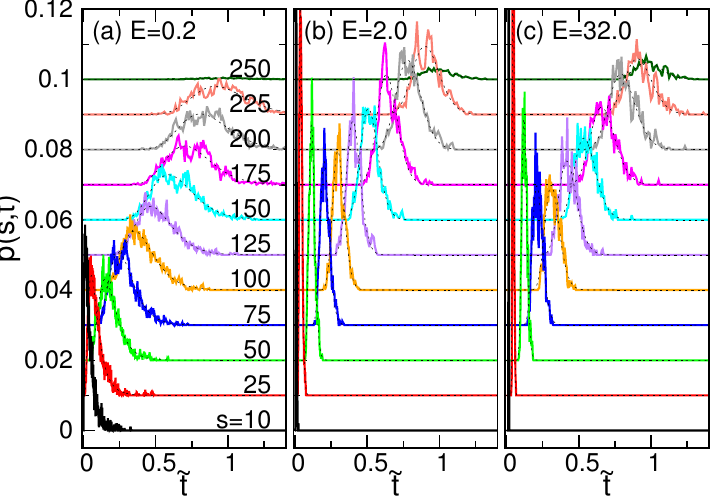
Figure 11. Probability densities p ( s , t ) versus the scaled time ˜ t for ( a ) E = 0.2, ( b ) 2.0 and ( c ) 32.0 at different translocation coordinates s indicated near the curves. For clarity, the curves have been shifted upward, one by one, by a fixed step. The dashed curves superimposed on the data are the results of fitting from Equation (19). The number of monomers of the chain N is